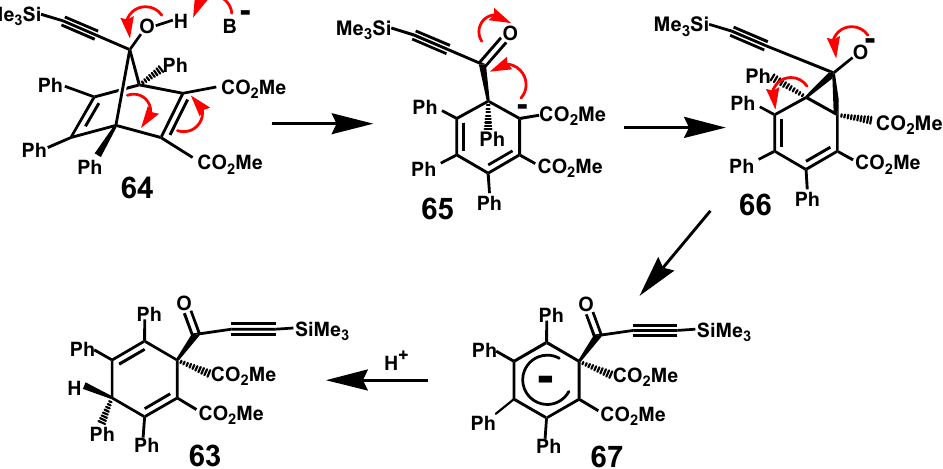
Scheme 23. Proposed mechanism for the rearrangement of norbornadiene 64 to cyclohexadiene 63